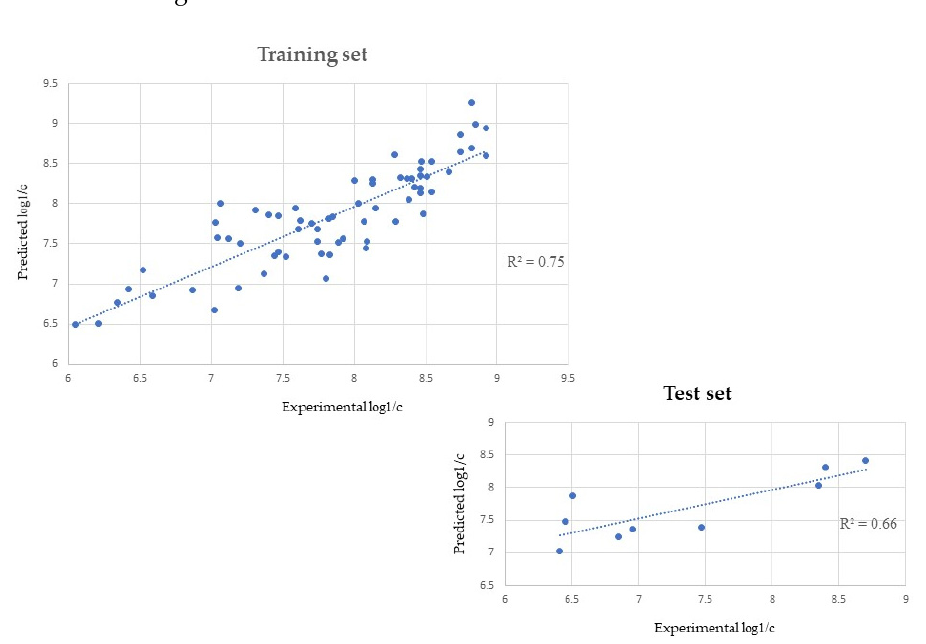
Figure 1. Correlation values (r 2 ) for the training and the test set were obtained using the 5-descriptors QSAR model generated by AutoQSAR. Note: In the two graphs, the values of log1/c experimentally derived (x axis) are plotted against the values predicted by the QSAR model (y axis). The r 2 defines the goodness of fit of the QSAR model. A QSAR model is considered acceptable when it has an r 2 value > 0.6 for the training set, and an r 2 > 0.5 for the test set. This model has, respectively, an r 2 of 0.75 and 0.66 for the training and test set.